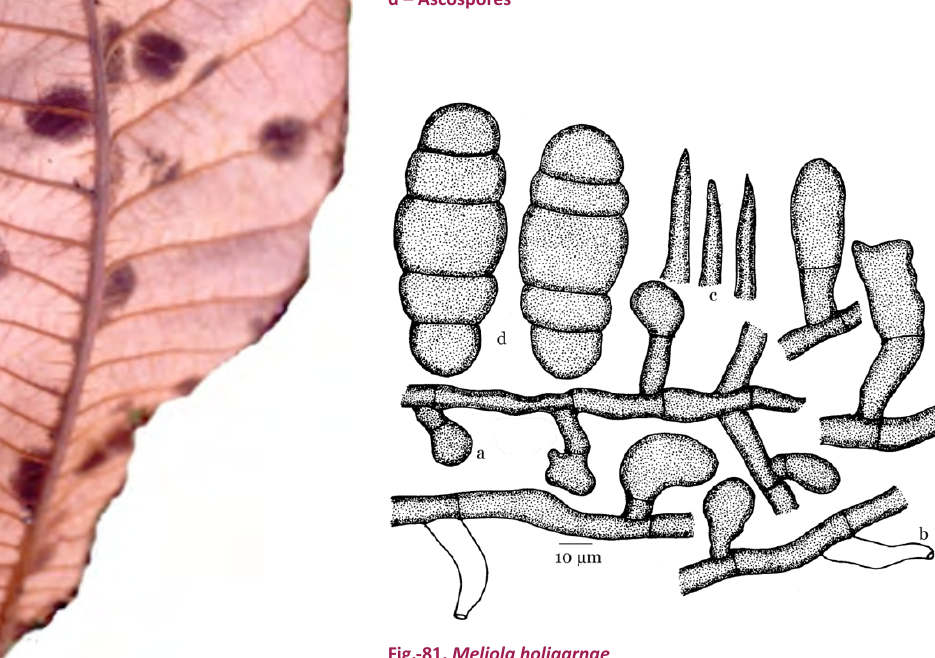
Figure-80. Meliola hemidesmicola a – Appressorium, b – Phialide, c - Apical portion of mycelial setae,